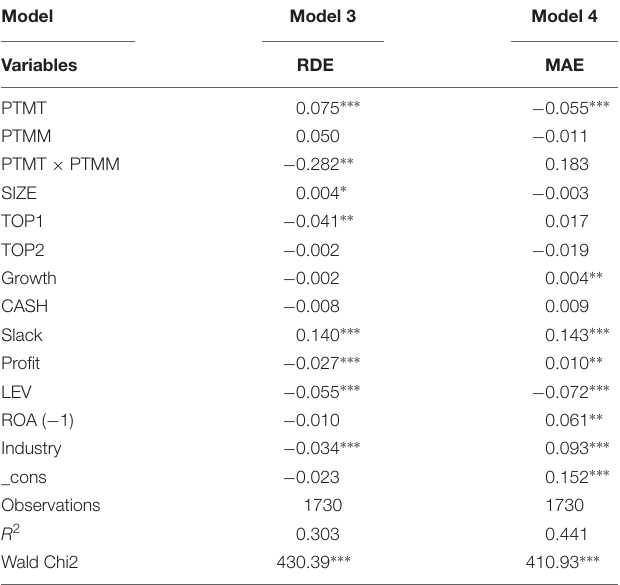
TABLE 3 | Results of interaction regression